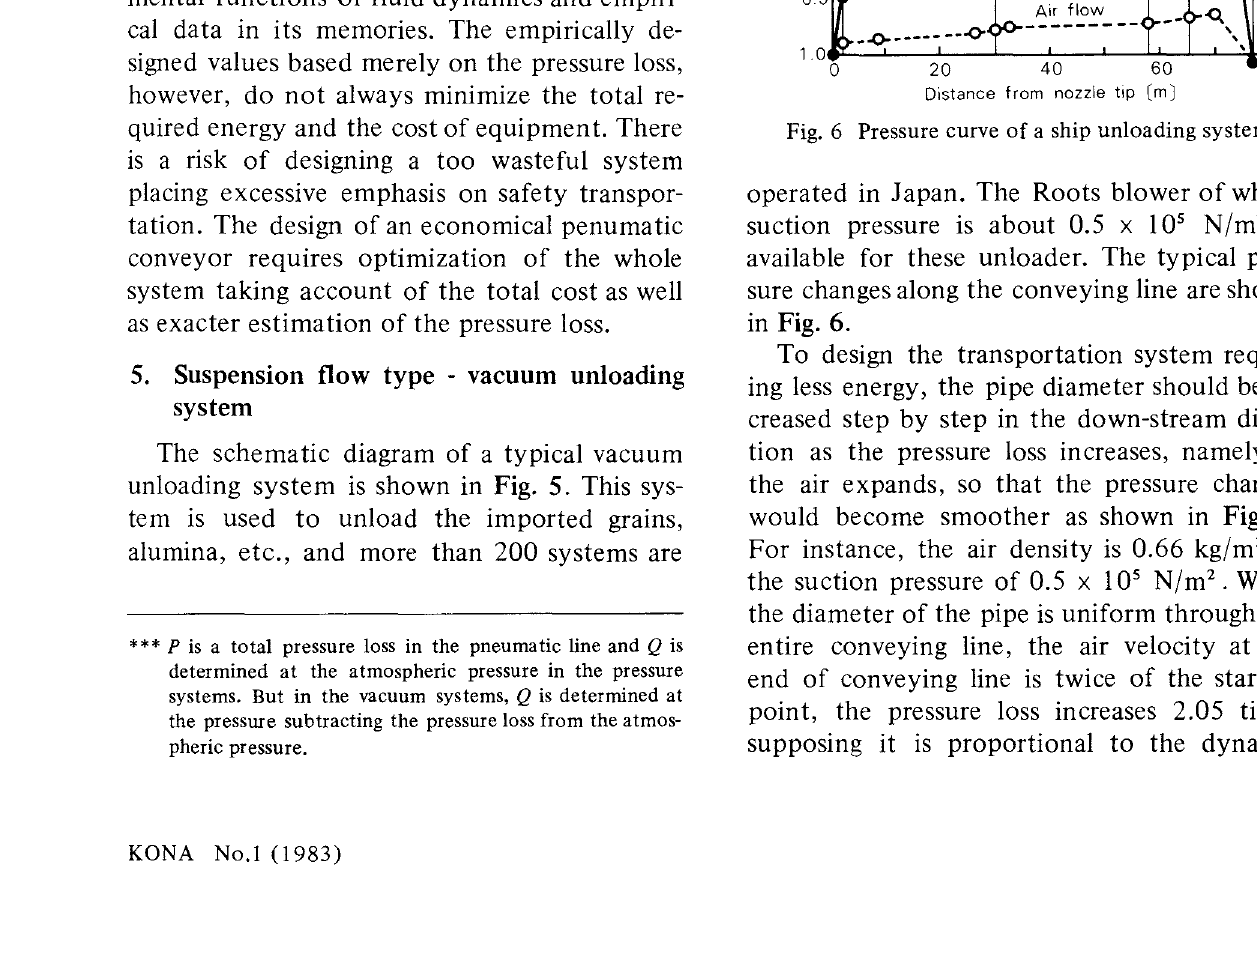
Fig. 6 Pressure curve of a ship unloading